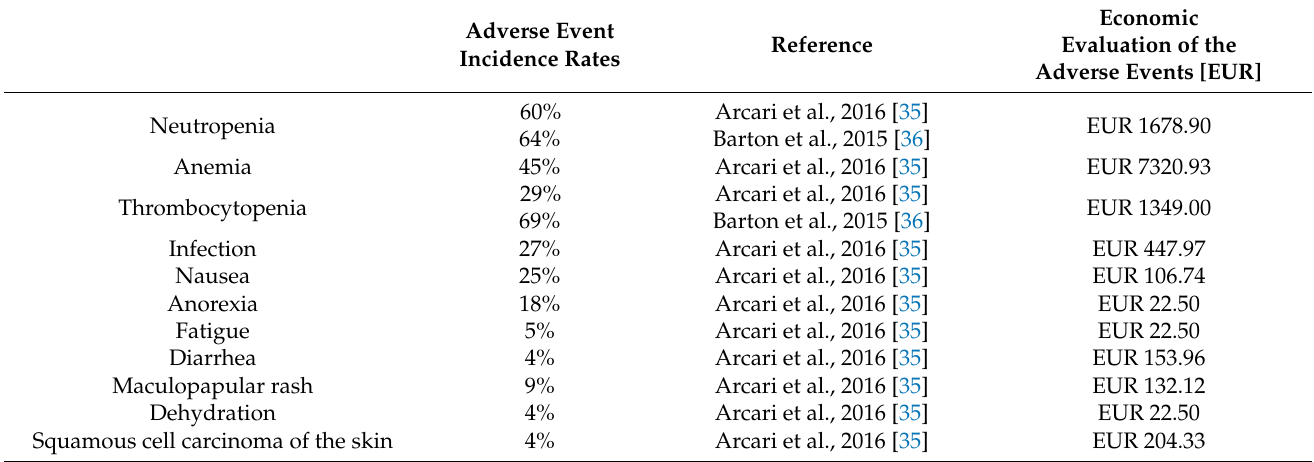
Table 3. BSC adverse event incidence rates in the literature and related economic